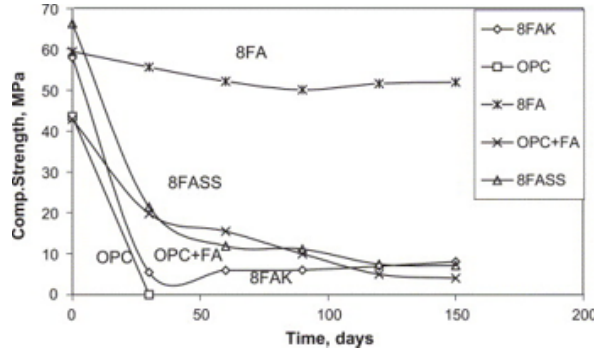
Figure 10: Compressive strength evolution of the geopolymer and Portland cement specimens exposed to 5% sulfuric acid solution [13]